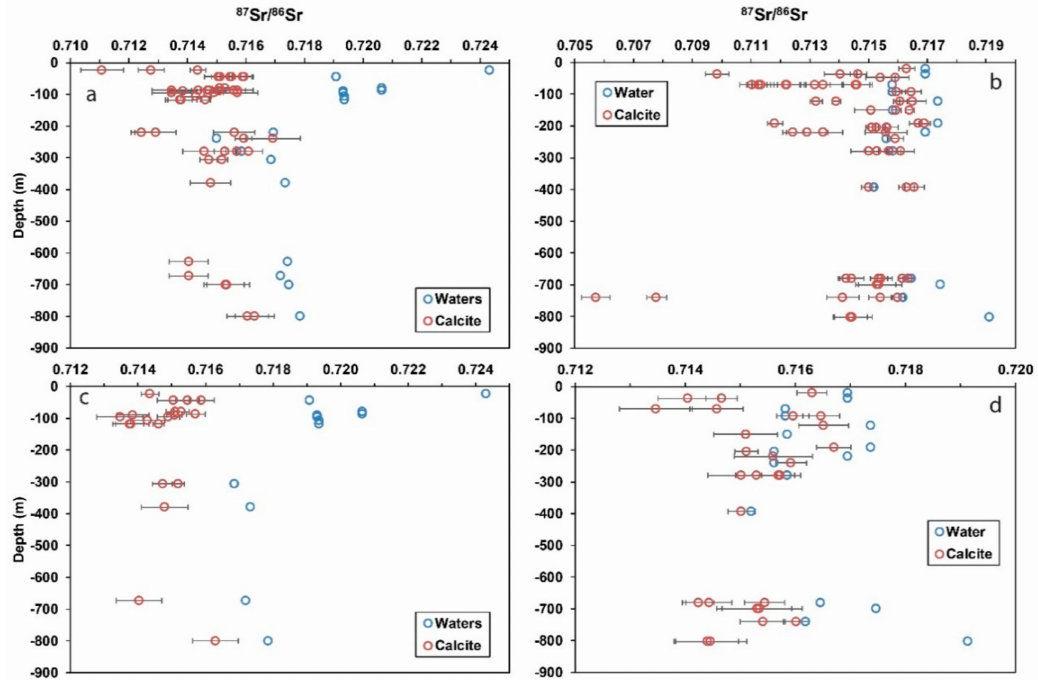
Figure 7. 87 Sr / 86 Sr values in calcite and 87 Sr / 86 Sr values of corresponding fracture water vs. depth for ( a ) Forsmark, all calcite spots, ( b ) Laxemar, all calcite spots, ( c ) Forsmark, outermost calcite growth zone, ( d ) Laxemar, outermost calcite growth zone. Error bars for the groundwater analyses are within the size of the